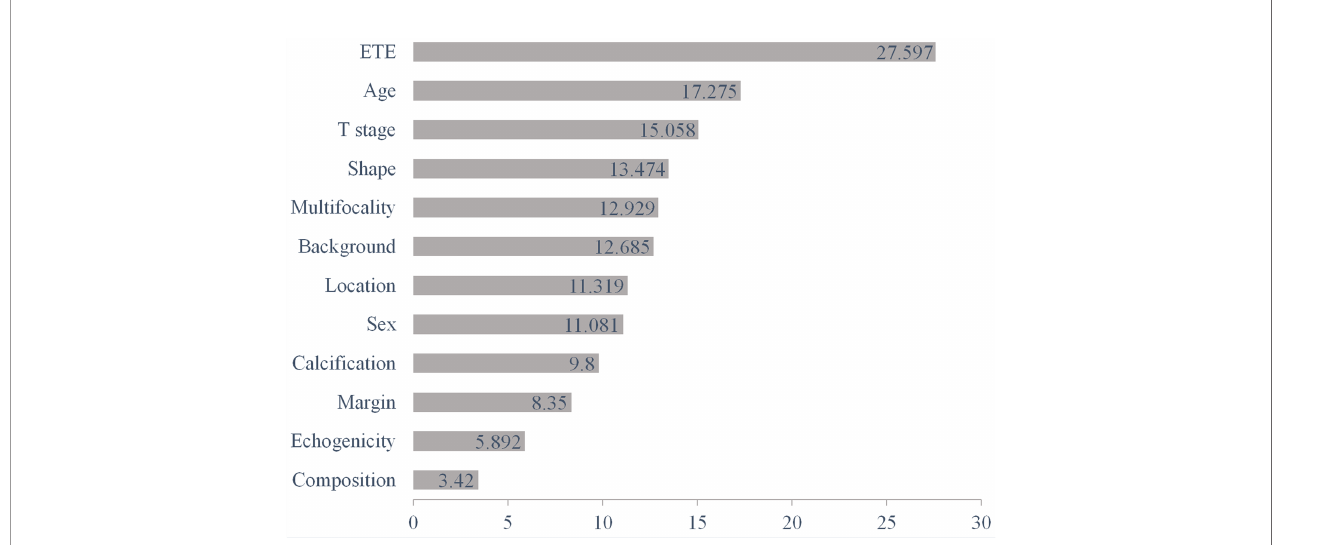
FIGURE 4 | The diagnostic performance of the RF algorithm was most dependent on the following fi ve top-rank features according to their mean decrease in Gini: ETE (27.597), age (17.275), T stage (15.058), shape (13.474), and multifocality (12.929). RF, random forest; ETE, extrathyroidal